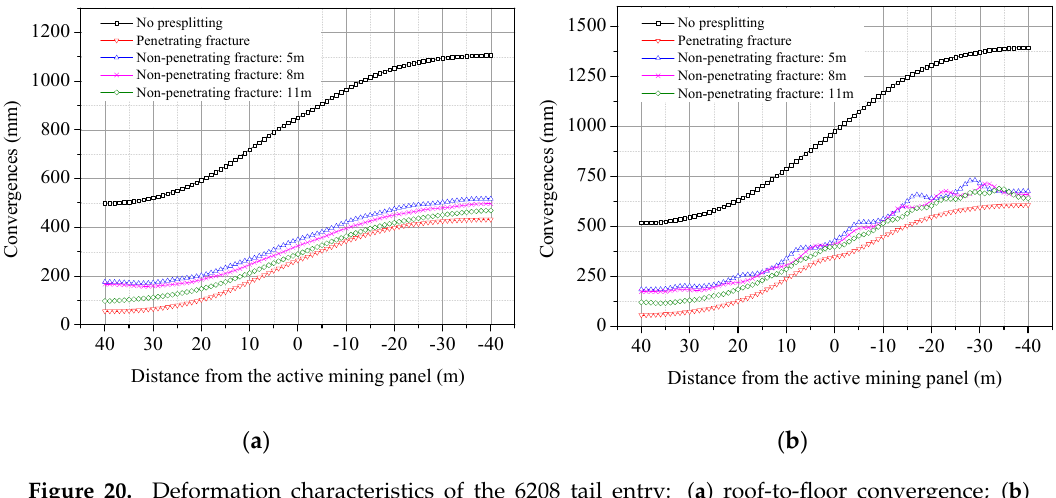
Figure 20. Deformation characteristics of the 6208 tail entry: ( a ) roof-to-floor convergence; ( b ) rib-to-rib convergence.